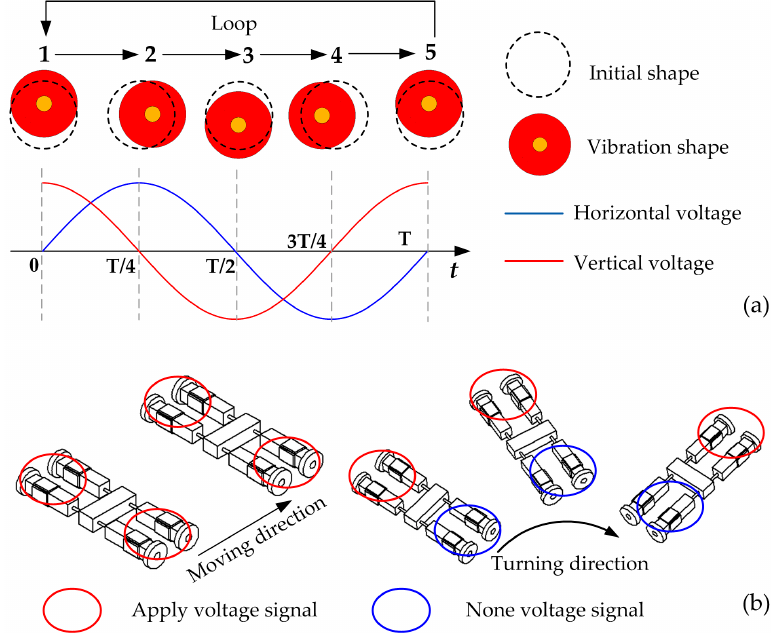
Figure 2. The operating principle: ( a ) Moving sequence of the driving foot; ( b ) Linear motion and turning motion.